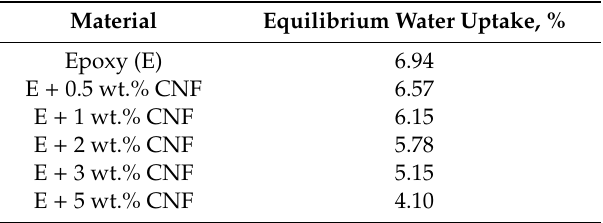
Figure 8. Water uptake of unfilled and CNF-filled epoxy nanocomposite series. Table 4. Water uptake properties of unfilled epoxy and CNF-filled epoxy nanocomposites.